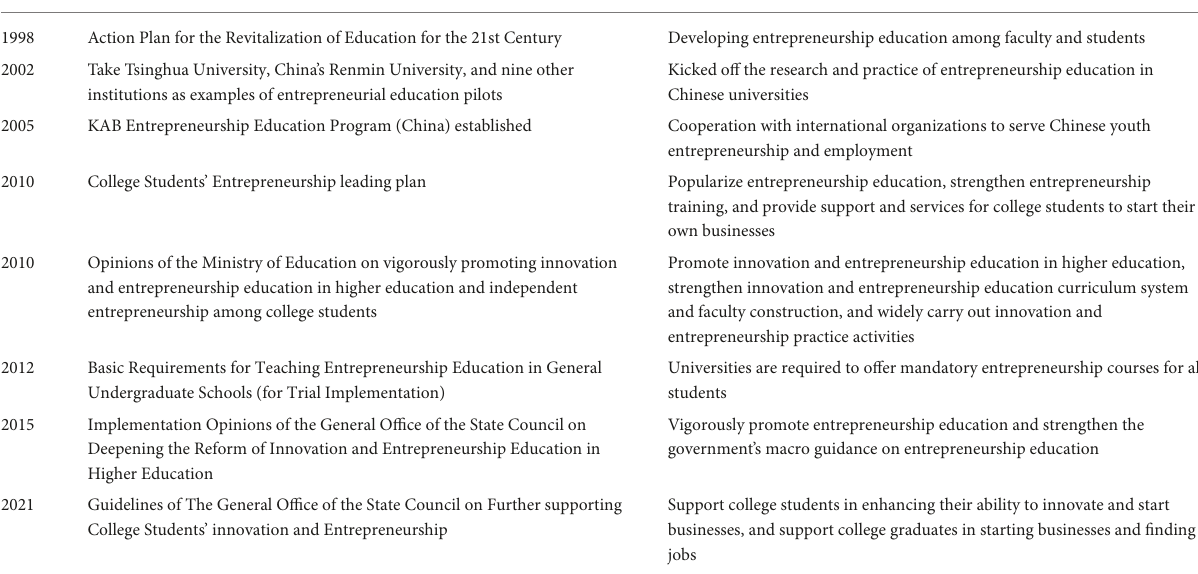
TABLE 1 Milestones of entrepreneurship education policies and initiatives in